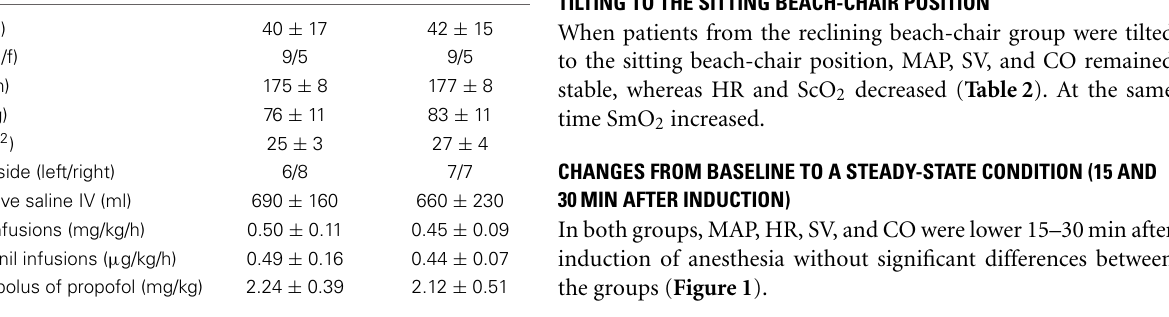
Table 2 | Circulatory and oxygenation parameters at baseline, following induction of anesthesia in either the sitting or reclining position, and during subsequent elevation to the sitting position in the patients in whom anesthesia was induced in the reclining position.